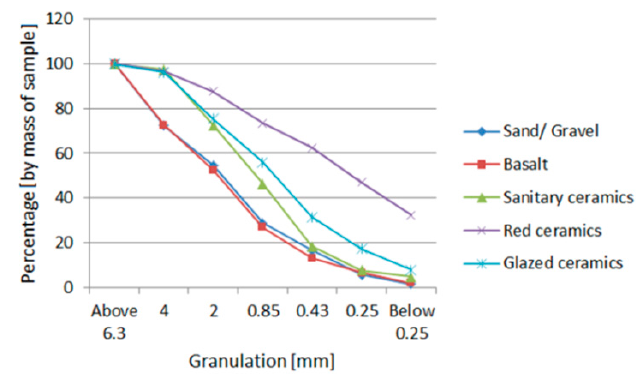
Figure 2. Grain size distribution curves for obtained aggregates.